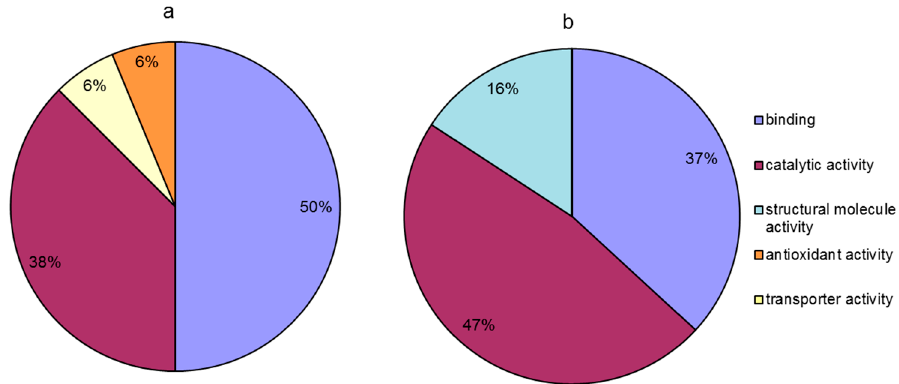
Figure 6. Molecular function of calcium-responsive proteins under temperature stress. ( a ) Calcium responsive proteins at 20 °C (20 °C + Ca vs. 20 °C); ( b ) calcium responsive proteins at 0 °C (0 °C + Ca vs. 0 °C).